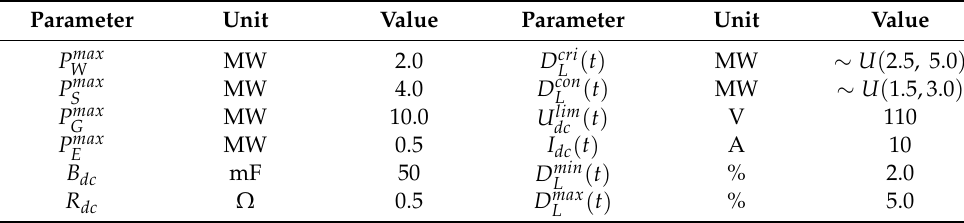
Table 2. 30-bus DCM-related